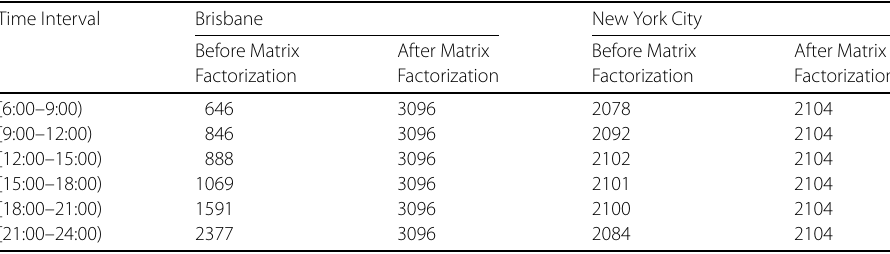
Table 3 Number of regions with dynamic features Time Interval Brisbane New York City Before Matrix After Matrix Before Matrix After Matrix Factorization Factorization Factorization